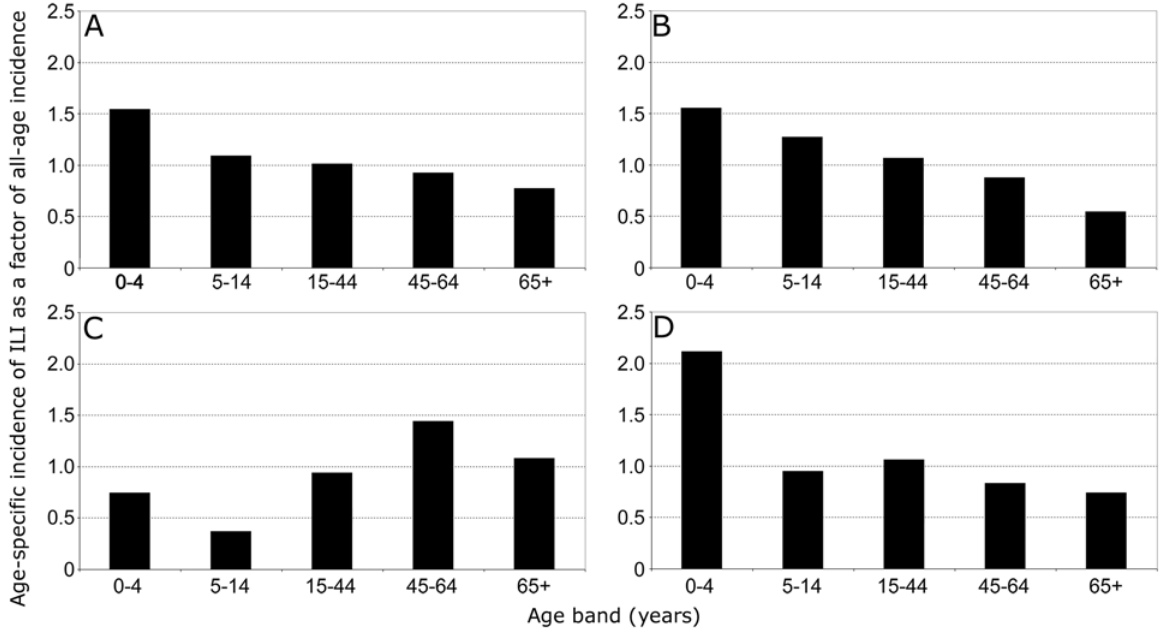
Figure 3. Clinical incidence rate of influenza-like illness (ILI) by age group expressed as a factor of the all-age incidence rate. Mean weekly incidence rates of ILI during influenza virus active weeks were calculated for winters: A) 1995/96 (A/Wuhan/359/95); B) 1997/98 (A/Sydney/5/ 97); C) 1999/00 (no new variant); and D) 2003/04 (A/Fujian/411/02).